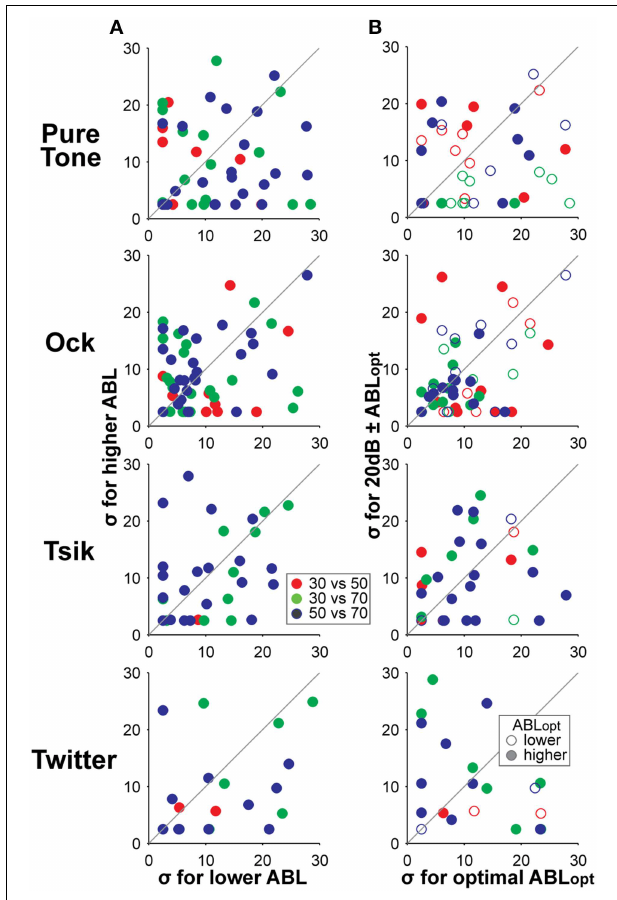
FIGURE 12 | Comparison of slopes of ILD-response functions at different ABLs. Column (A) compares the slope of the ILD-response function as indicated by the fitted parameter σ , for lower (x-axis) and higher (y-axis) ABL. The ABL of the stimuli are indicated by the color coding according to the legend. Column (B) compares the slopes of the tuning curves when the ABL was varied from ABL opt (x-axis) to one that is non-optimal (y-axis). In addition to the color code indicating stimulus ABL, we also indicate whether the ABL opt of the cells was higher or lower than the comparison ABL using the legend in the bottom plot; i.e., a green filled data point indicates that the ABL opt is 70dB SPL and the comparison is made against its response to 30dB ABL. Different rows show data in response to different stimuli. All responses shown here have tuning-invariant